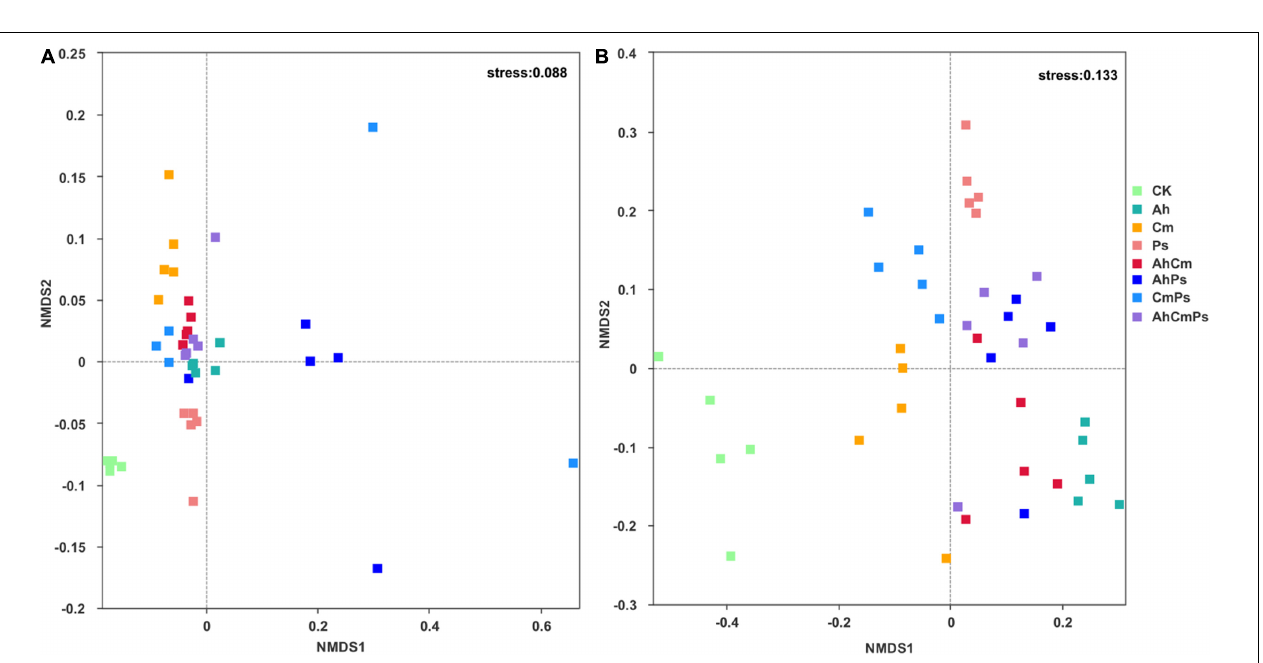
FIGURE 5 | Non-metric multidimensional scaling (NMDS) analysis of (A) bacterial and (B) fungal community structures under different litter input.